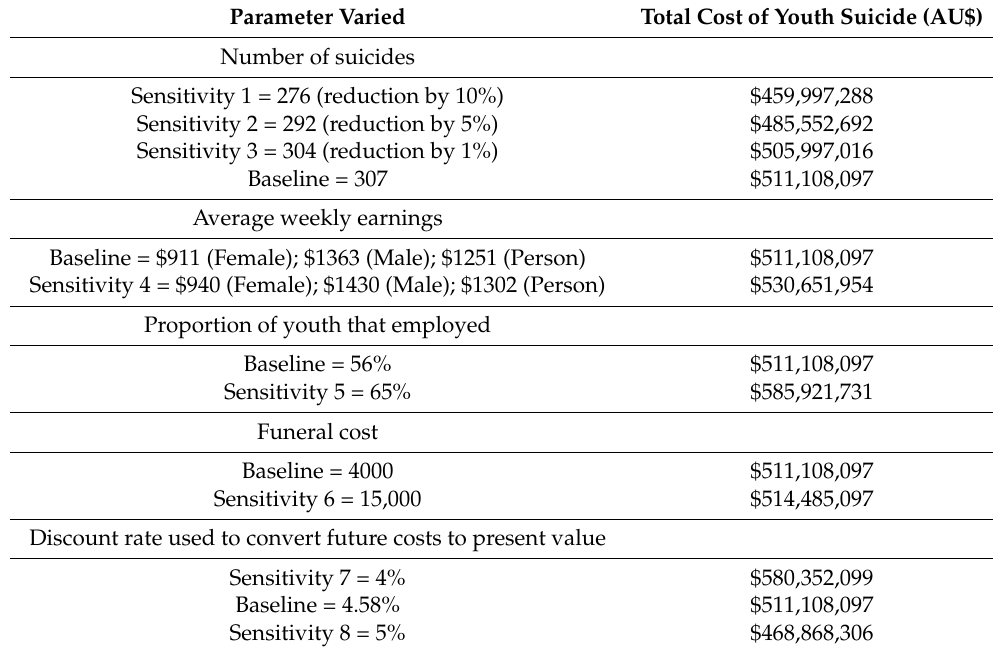
Table 6. Sensitivity analysis of key parameters (in